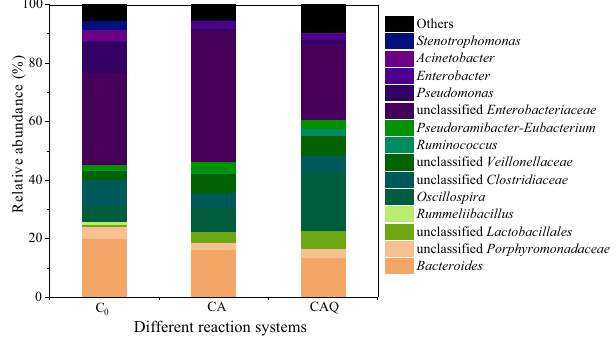
Figure 7. Relative abundance of species at bacterial genus level (relative abundance > 1%). C 0 , Initial bacterial consortium; CA, the bacterial consortium in the control system without AQ-GO after 35 d; CAQ, the bacterial consortium in AQ-GO supplemented system after 35 d.